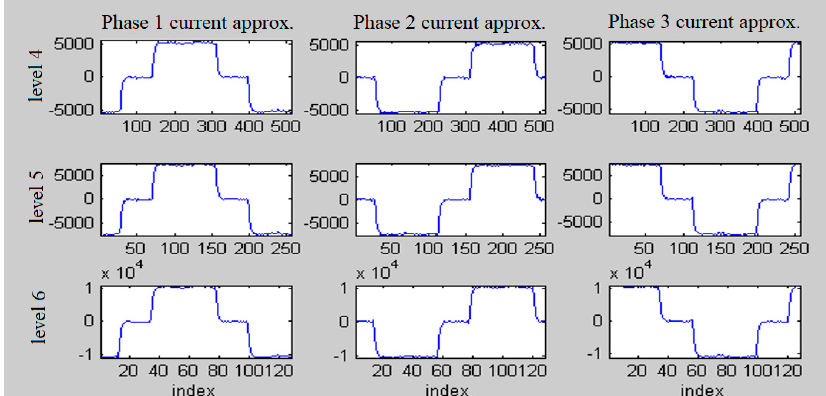
Figure 15. Vectors of approximations for currents, levels 4–6, first case study.